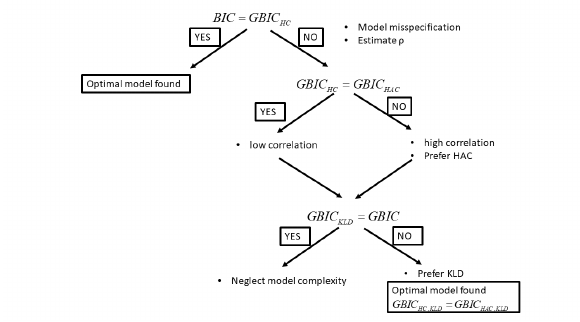
Fig. 1. Interpretation of the differences between the generalized BIC and the BIC by accounting for model complexity and misspecifica-